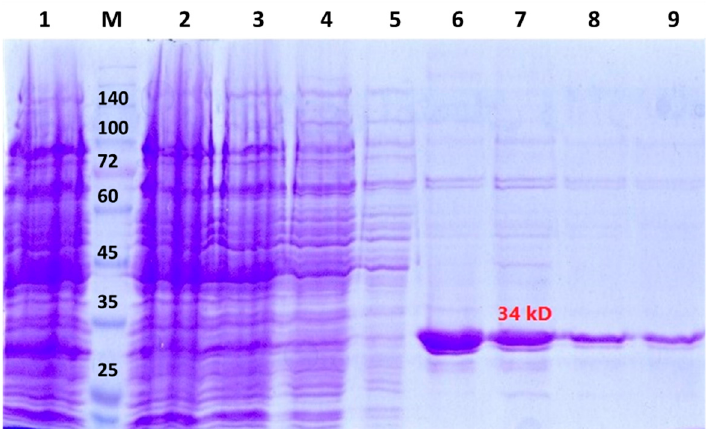
Figure 1. SDS-PAGE analysis of the purified recombinant Uox. Lane 1 shows the total proteins expressed in E. coli . Lane M is the standard weight protein marker. Lanes 2, 3, 4, and 5 represent the 1, 3, 6, and 14 washing samples. Lanes 6–9 show the eluted samples of the purified recombinant Uox.